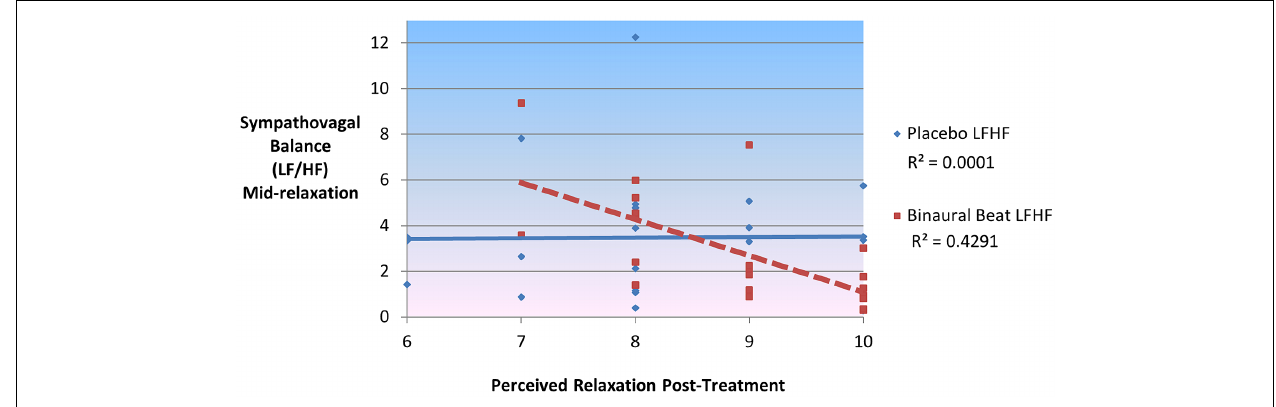
FIGURE 6 | Sympathovagal balance (LF/HF) mid-relaxation predicts 43% of variance in self-reported ratings of perceived relaxation in binaural-beat but not placebo